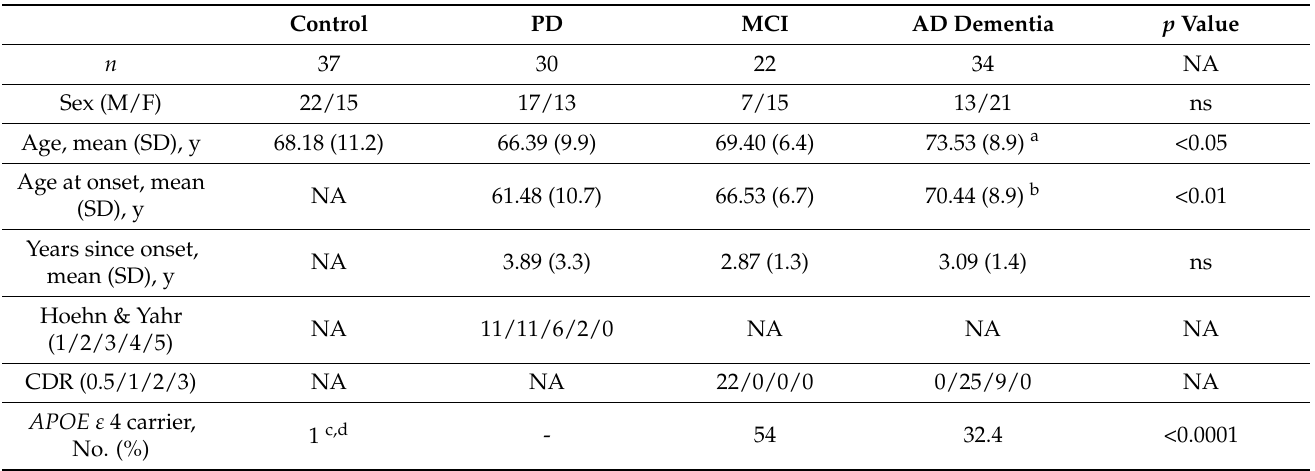
Table 1. Demographic and clinical data of